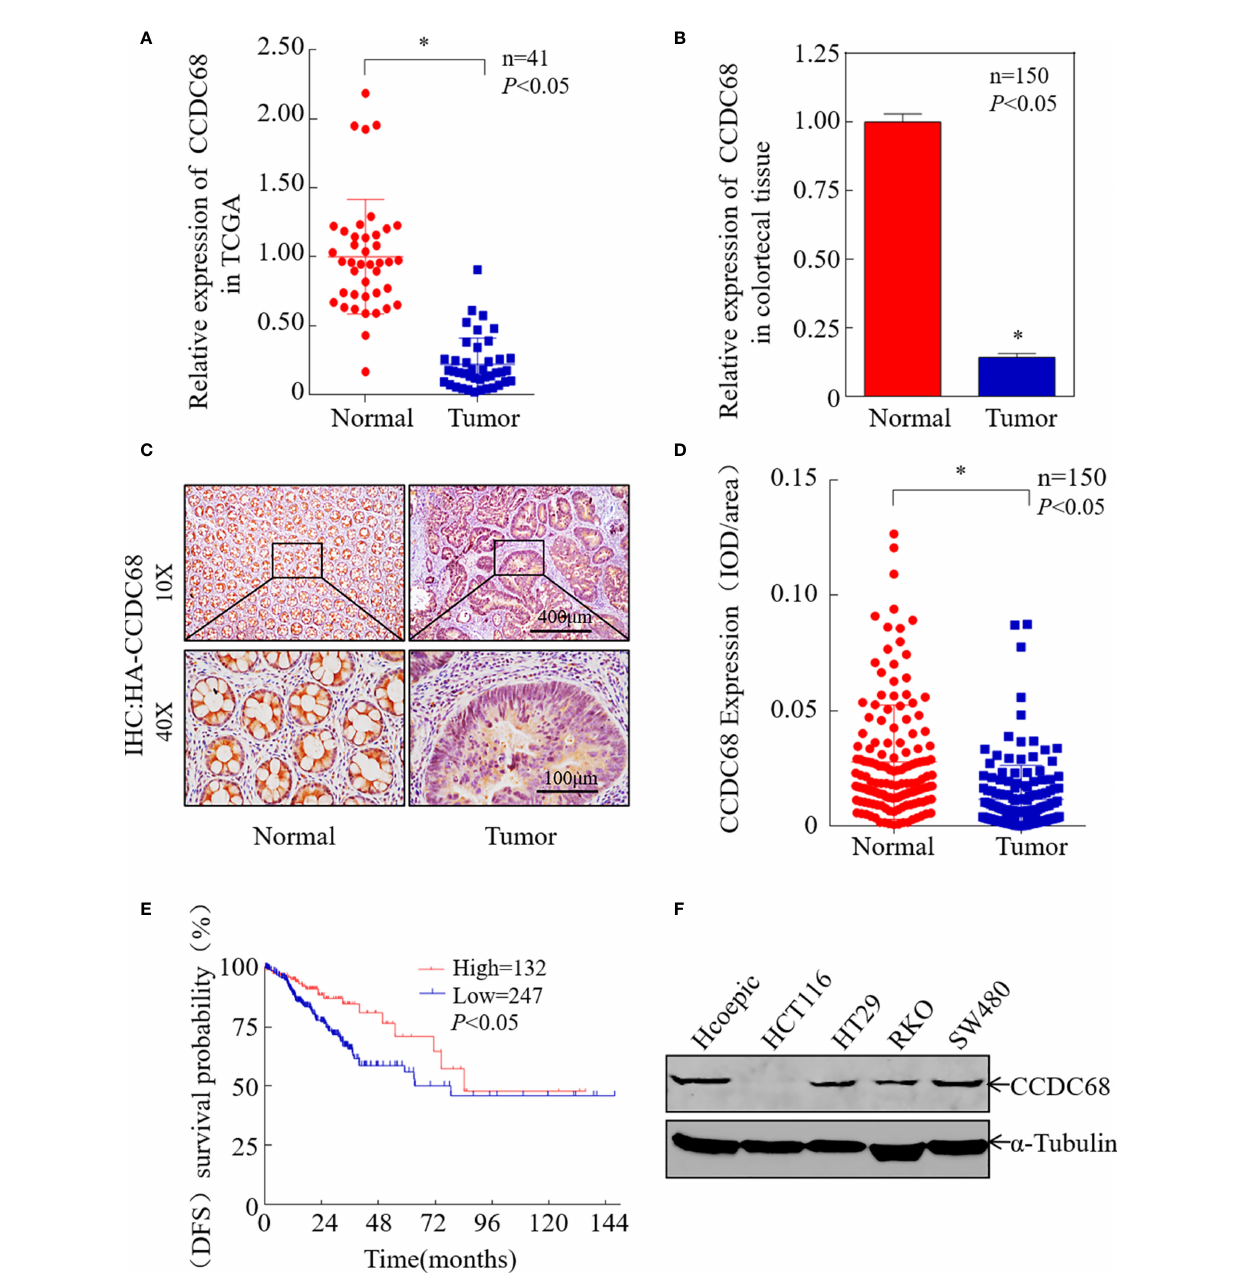
FIGURE 1 | CCDC68 is downregulated in CRC tissues and cells. (A) CCDC68 mRNA levels in CRC according to the Cancer Genome Atlas (TCGA) data. (B) The mRNA expression level of CCDC68 in 150 pairs of CRC tissues and paracancerous tissues (normal). (C) Representative IHC images of CCDC68 protein expression in CRC tissues and adjacent normal tissues. (D) Quanti fi cation of CCDC68 expression in 150 pairs of CRC tissues and adjacent normal tissues. (E) CCDC68 mRNA expression levels and disease-free survival of patients from TCGA CRC data. (F) Expression of CCDC68 in human CRC cell lines (HCT116, HT29, RKO, and SW480) and in the normal colorectal epithelial cell line HCoEpiC. Data are presented as the mean ± SD, * P <